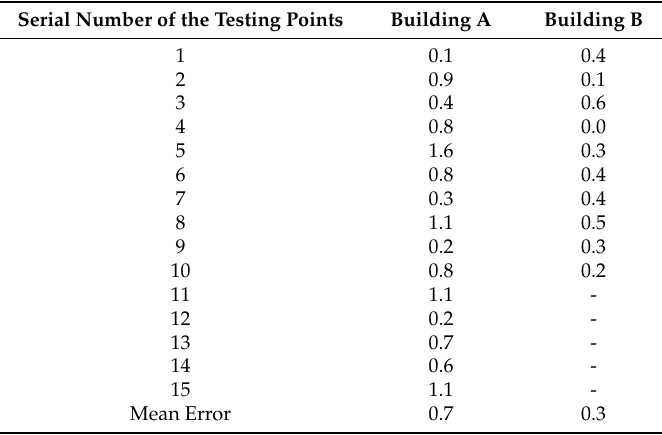
Table 3. Reconstruction errors of testing